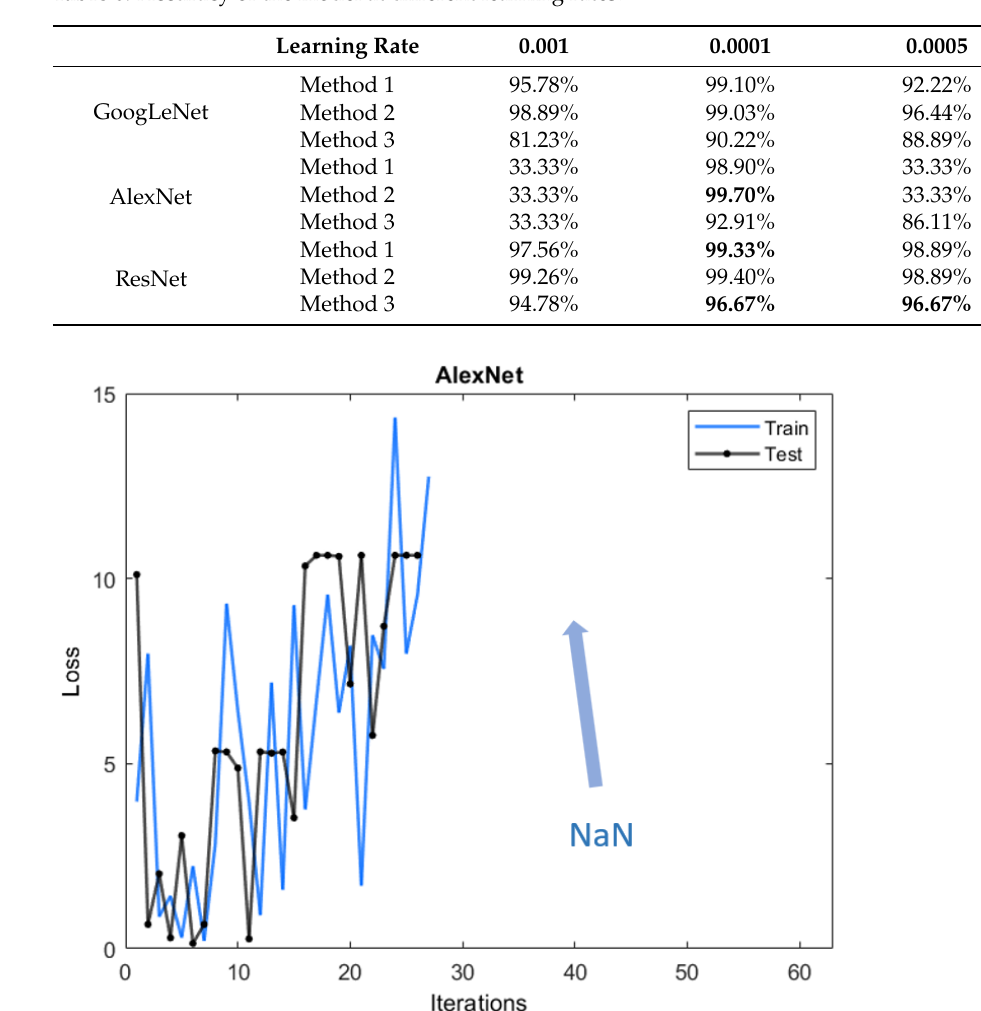
Table 6. Accuracy of the model at different learning rates.